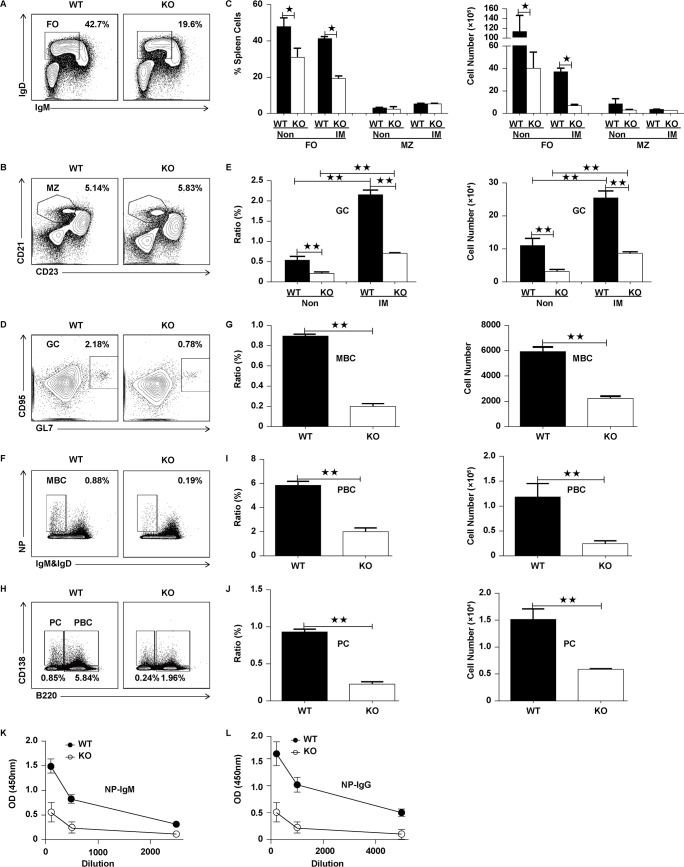
Rictor deficiency reduces the humoral immune response.Flow cytometry analysis of folicular (FO) and marginal zone (MZ) B cells in spleen of wild-type (WT) and Rictor knockout (KO) mice (n = 8) immunized with 4-hydroxy-3-nitrophenylacetyl–keyhole limpet hemocyanin (NP-KLH) (A). The quantification of percentage (B) and number (C) of FO and MZ B cells in the spleen of WT and Rictor KO mice. Flow cytometry analysis of germinal center (GC) B cells in the spleen of WT and Rictor KO mice immunized with NP-KLH (D). The quantification of percentage and number of GC B cells in the spleen of WT and Rictor KO mice (E). Flow cytometry analysis of memory B (MBC), plasmablast (PBC), and plasma cell (PC) cells in the spleen of WT and Rictor KO mice immunized with NP-KLH (F and H). The quantification of percentage and number of MBC, PBC, and PC cells in the spleen of WT and Rictor KO mice (G, I, and J). Mean results from ELISA detecting NP-specific immunoglobulin M (IgM) and Immunoglobulin G1 (IgG1) from immunized WT and Rictor KO mice (n = 6) (K). T-test was used to do the statistics, **p < 0.001. The numerical data (for C, E, G, I, J, K, and L) can be found in S1 Data.